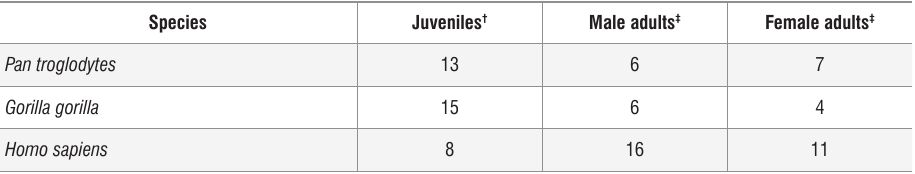
Summary of hominoid sample used to create developmental